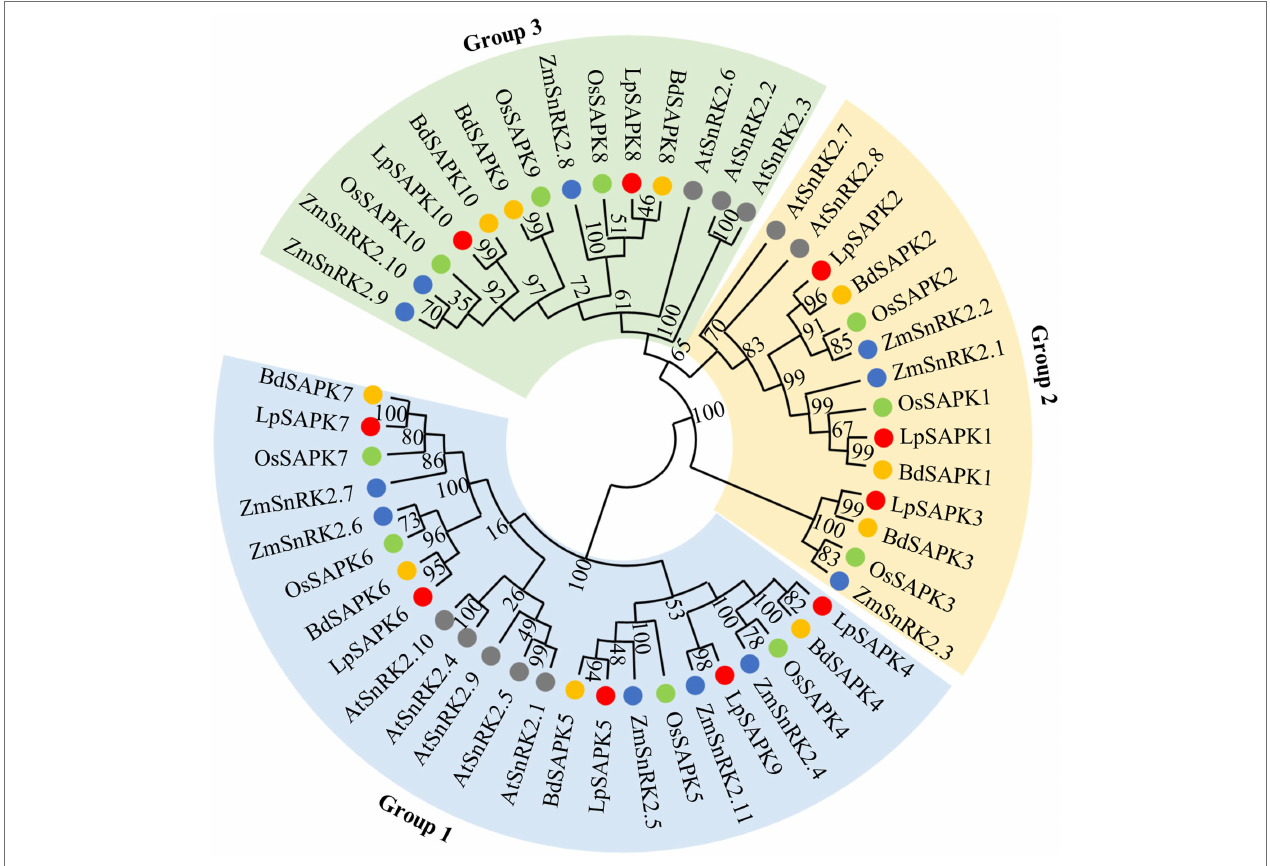
FIGURE 2 | Phylogenetic analysis of SAPK/SnRK2 proteins from Arabidopsis (AtSnRK2s), rice (OsSAPKs), and maize (ZmSnRK2s), brachypodium (BdSAPKs), and perennial ryegrass ( LpSAPKs ). The phylogenetic tree was constructed using the neighbor-joining (NJ) method with 1,000 bootstrap replicates in MEGA7.0. The Genebank accession numbers of LpSAPK , AtSnRK2, OsSAPK2, ZmSnRK2, and BdSAPK proteins are listed in Supplementary Tables S2 , S3